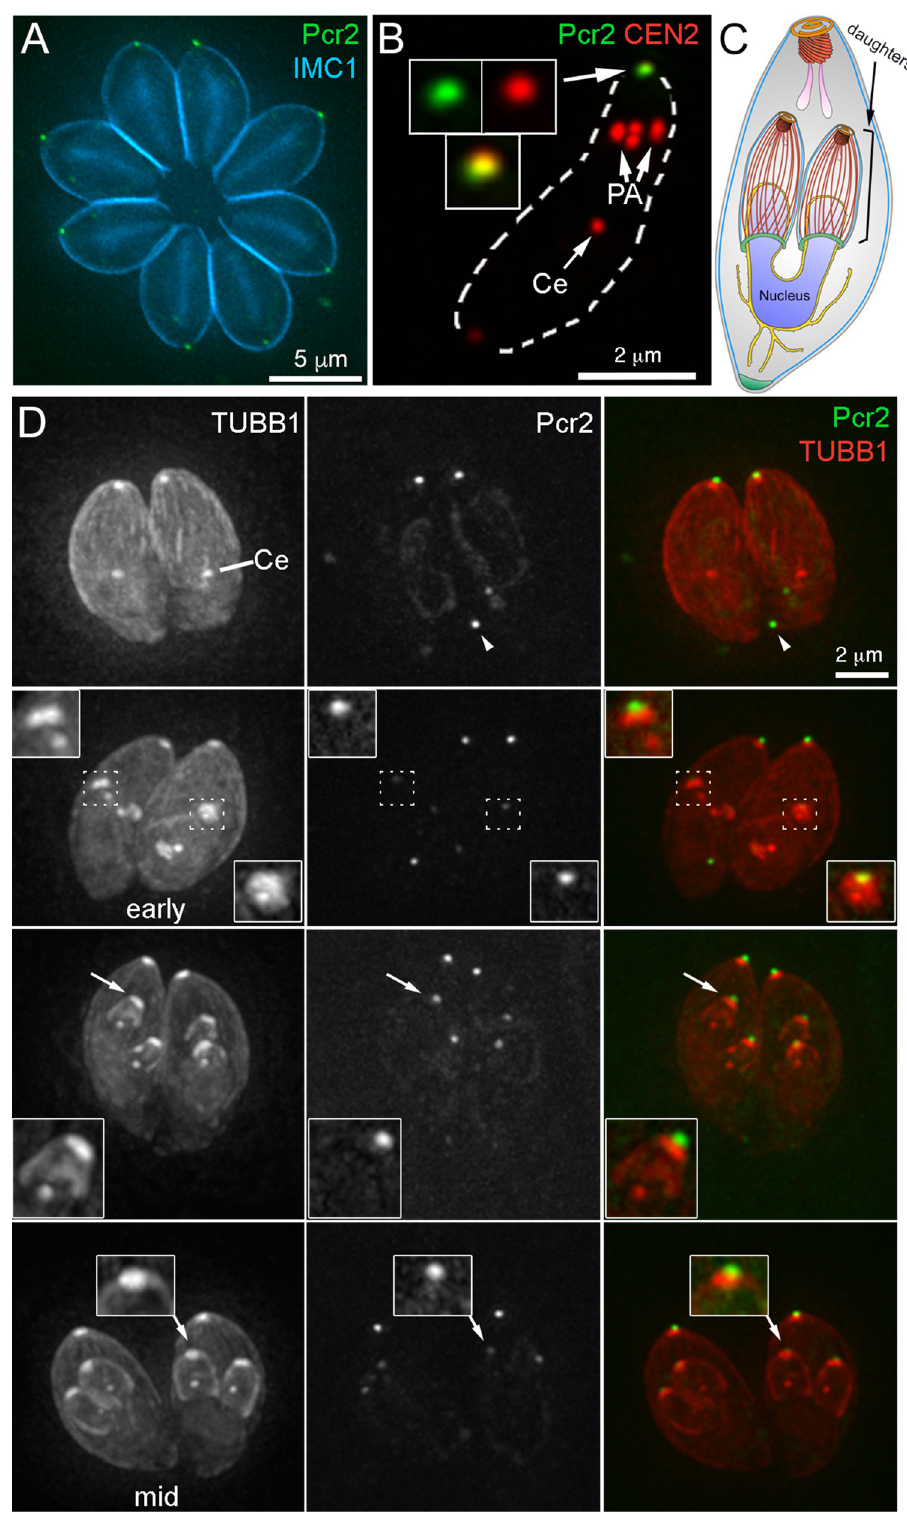
Fig 3. Pcr2 is recruited to the preconoidal region at an early stage of daughter formation. A. Projection of deconvolved wide-field images of intracellular Pcr2-mNeonGreen 3’ endogenous tag parasites (green) labeled with a mouse anti-IMC1 antibody and a secondary goat anti-mouse Alexa350 antibody (cyan). B . Projection of